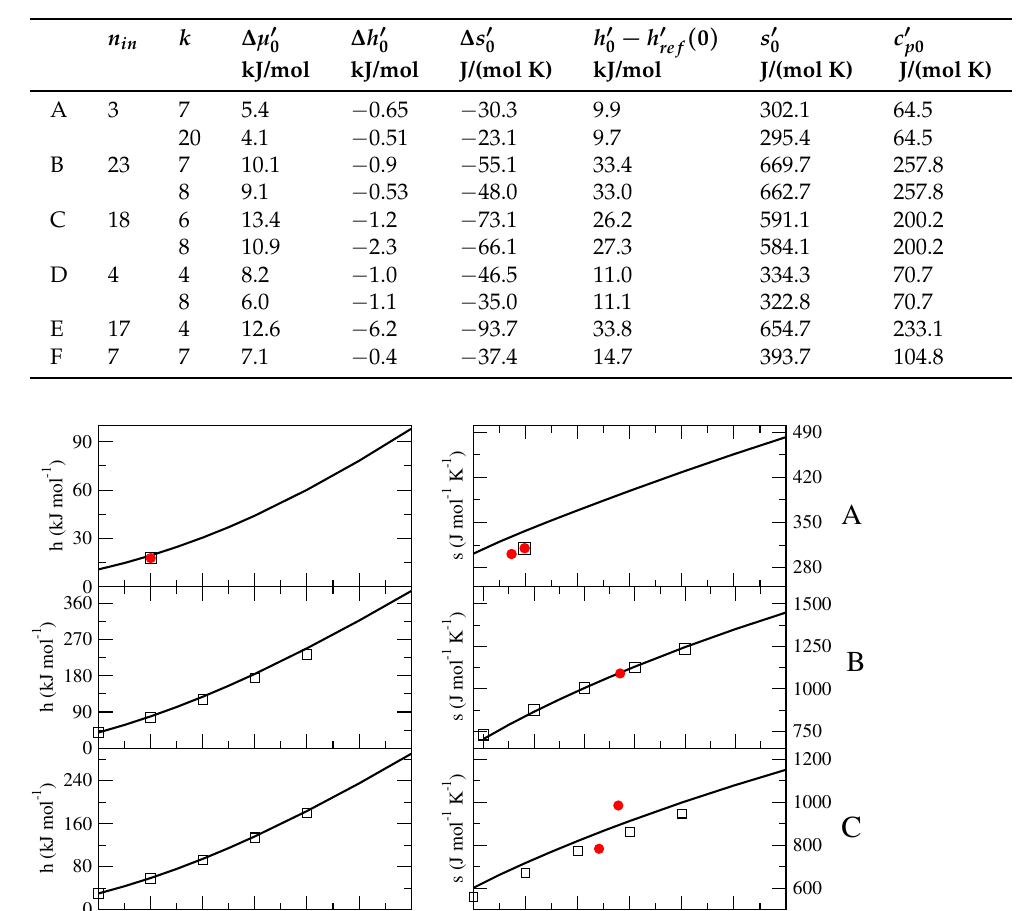
Table 1. Excess molecular free energy, enthalpy and entropy differences as obtained from MD ref at T 0 = 200 K using the largest k value compatible, within either 95 percent (left numbers) or the 99.9 percent (right numbers) confidence, with the harmonic assumption for the reference conforma- tion (see Computational Details section), with the corresponding standard-state molecular excess ( 0 ) ) and entropy at T enthalpy (with respect to h (cid:48) 0 , as obtained from Equations (27)–(29), and the ref molecular excess heat capacity, as provided by the MD simulations at the different temperatures ( n in indicates the number of semi-classical internal degrees of freedom). A = n-butane, B = BmimNTf 2 , C = BmimPF 6 , D = n-butanol, E = octadecane and F = n-octane. Note that for E and F, a single value of k is reported, corresponding to 95 percent confidence; for any larger k , we could not find conditions within 99.9 percent confidence (i.e., deviations between the MD mean potential energy and the expected harmonic value are too large).